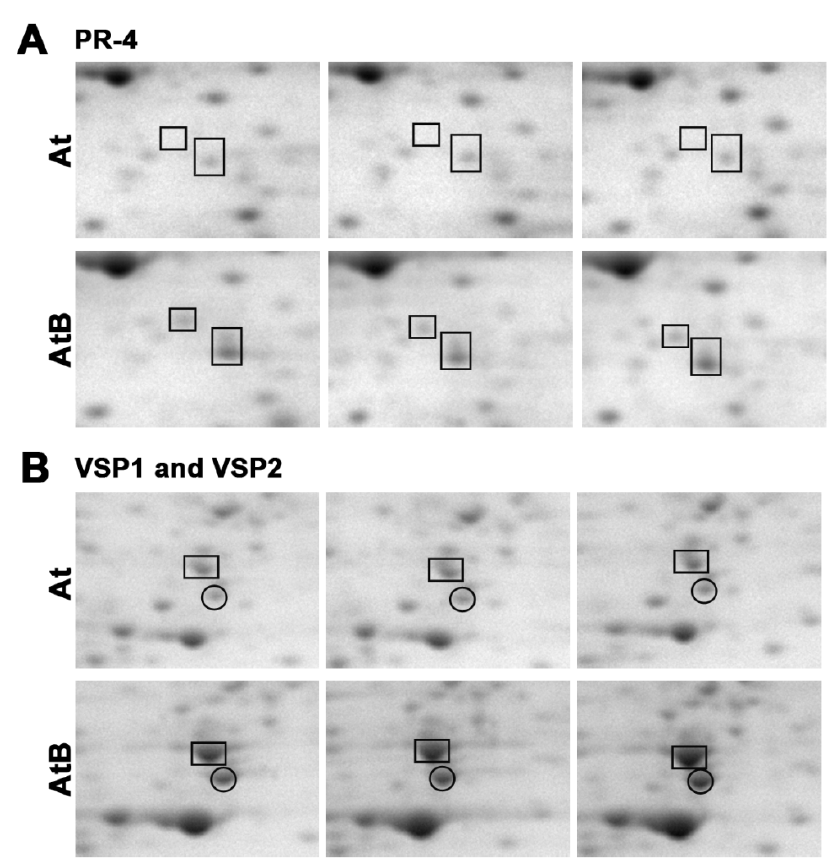
Figure 1. Induction of defense proteins by the rolB gene. Fragments of two-dimensional gels of protein fractions from the control (At) and rolB- transformed AtB-1 (AtB) plants obtained in three separate experiments are presented. Gels were scanned using a VersaDoc MP 4000 system with PDQuest 8.0.1 Advanced software as described in Section 4.3. Protein expression is presented as the average total spot intensity in a group of three repeated gels. ( A ) hevein-like preproprotein PR-4/HEL, marked with boxes (this protein was divided on gels into two isoforms by isoelectric mobility and by mass); ( B ) vegetative storage protein 1 (VSP1, boxes) and vegetative storage protein 2 (VSP2, circles).